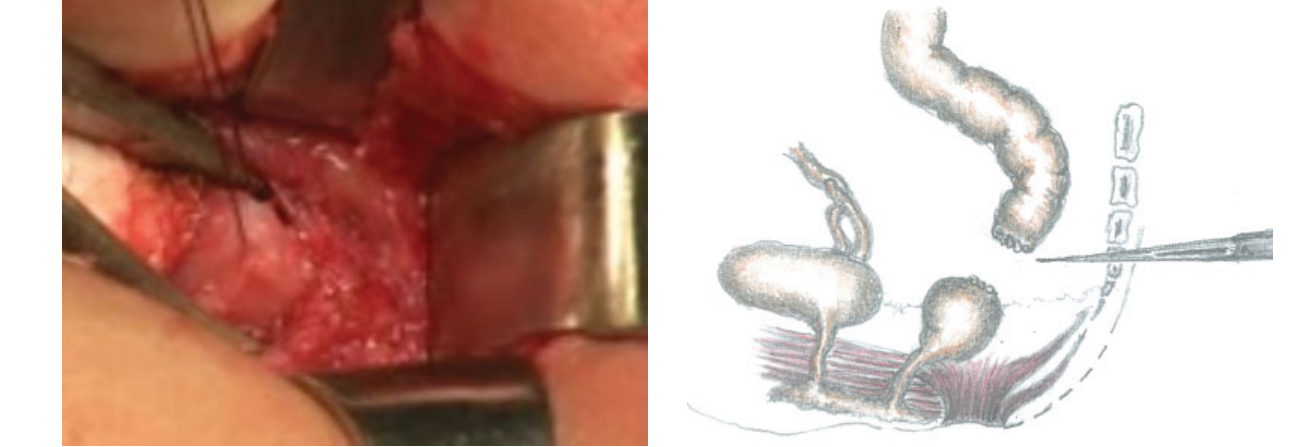
Fig. 3 Sigmoid colon surgically separated from the dilated